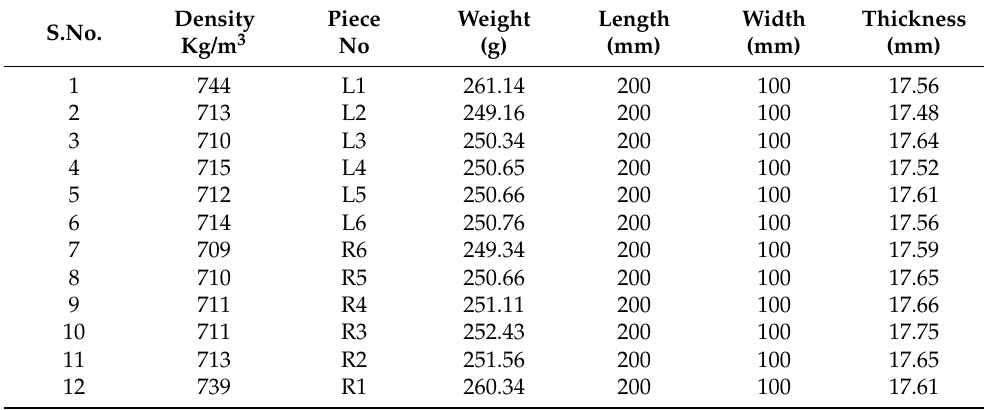
Table 4. Density profile across